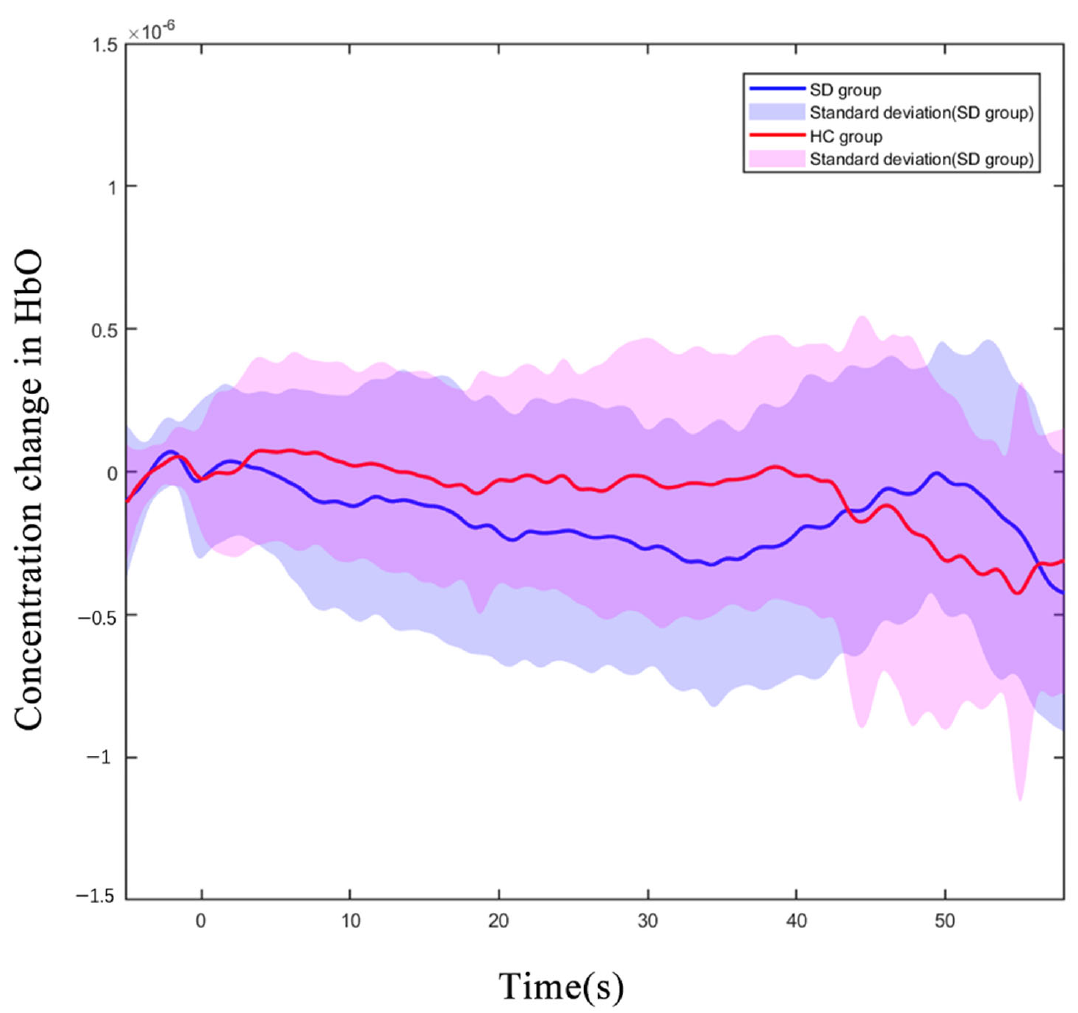
Figure 3. Oxygenated hemoglobin concentration changes in the HC and SD. Average oxy-Hb signal waveform of CH8 for 3 executions of 2-back task. The oxy-Hb signals of the SD group are displayed in blue, and the signals of the HC group are displayed in red. (X-axis: time process of executing 2-back tasks; Y-axis: oxygenated hemoglobin concentration level).